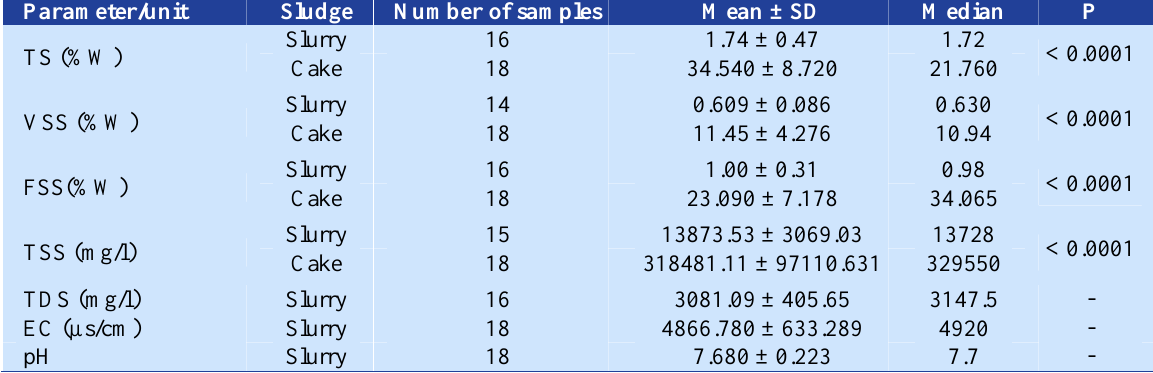
Table 1. Physicochemical characteristics and statistical results of slurry and cake sludge